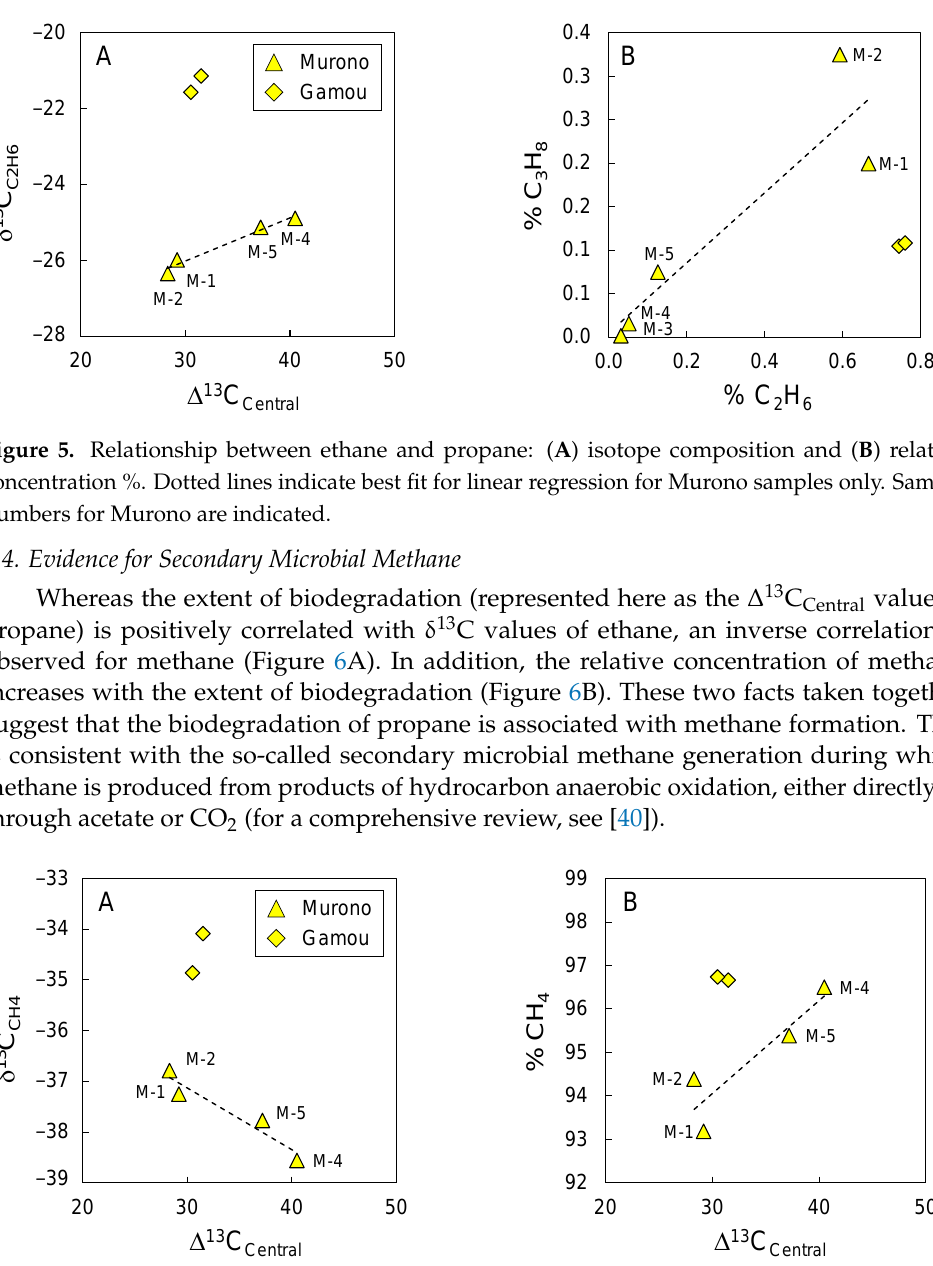
Figure 6. Relationship between the ∆ 13 C Central of propane and ( A ) the isotope composition of methane and ( B ) the relative concentration of methane (% CH 4 ). Dotted lines indicate best fit for linear regression for Murono samples only. Sample numbers for Murono are